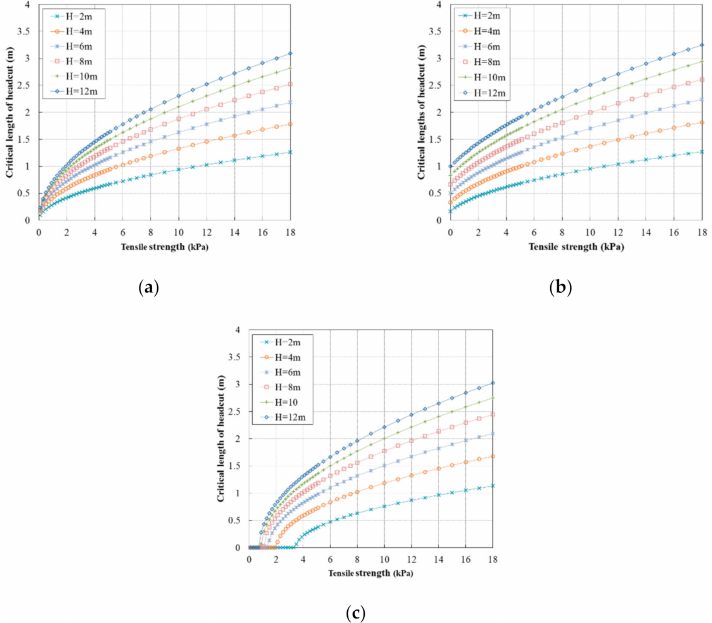
Figure 5. The critical lengths of the headcuts under di ff erent soil tensile strengths for a range of embankment heights ( H ) from 2 to 12 m. ( a ) β i = 1; ( b ) β i = 0.5; ( c ) β i =